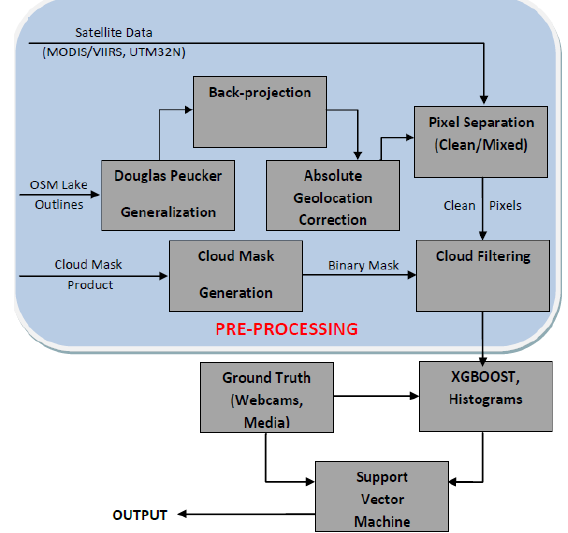
Figure 4: Flowchart of the lake ice detection